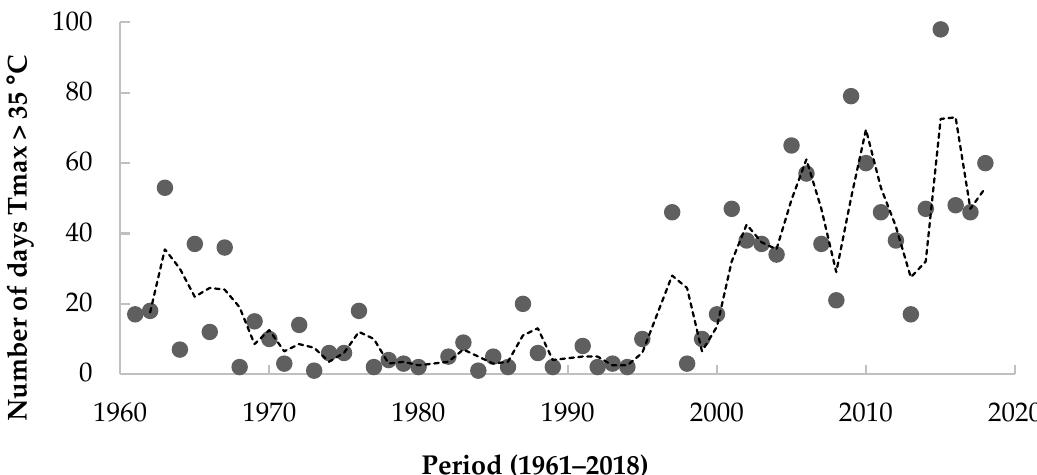
Figure 7. Temporal distribution of the index of the number of annual days with maximum temperature above the 90th percentile (35 °C) in the period from 1961 to 2018.Data from INMET station 82331, 2020. Elaborated by authors.